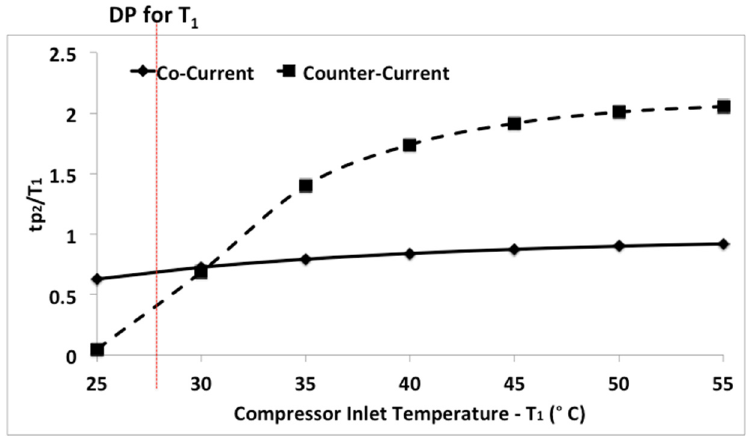
Figure 8. Heat Sink Outlet Temperature for ICR. The heat sink outlet temperature is normalised by the respective cycle/compressor inlet temperatures. Appl. Sci. 2017 , 7, 319 12 of 19